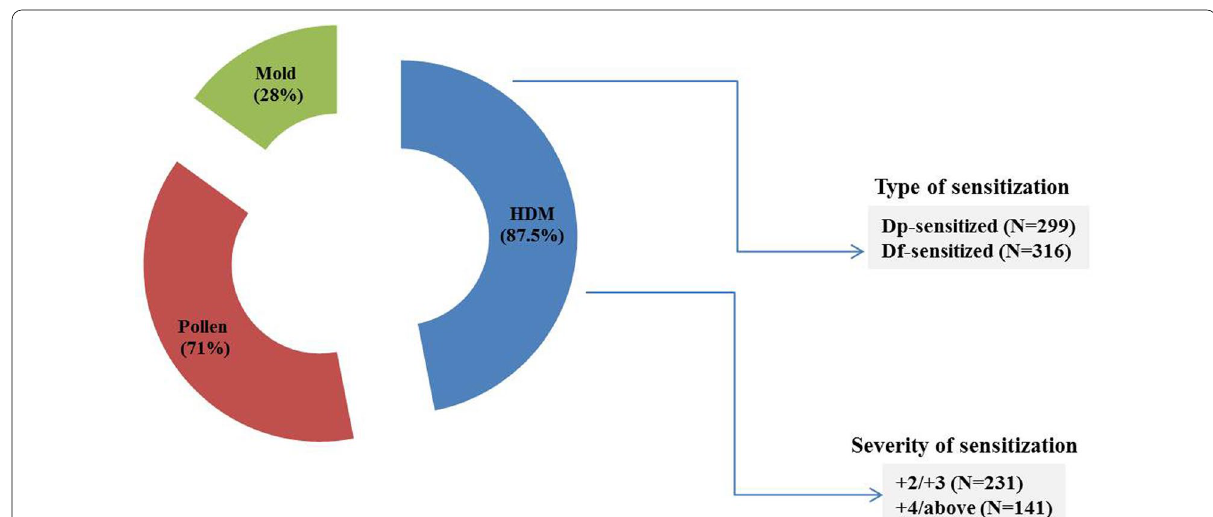
Fig. 1 Overall sensitization pattern of the studied group and the scheme of categorization of patients according to HDM sensitization (type and